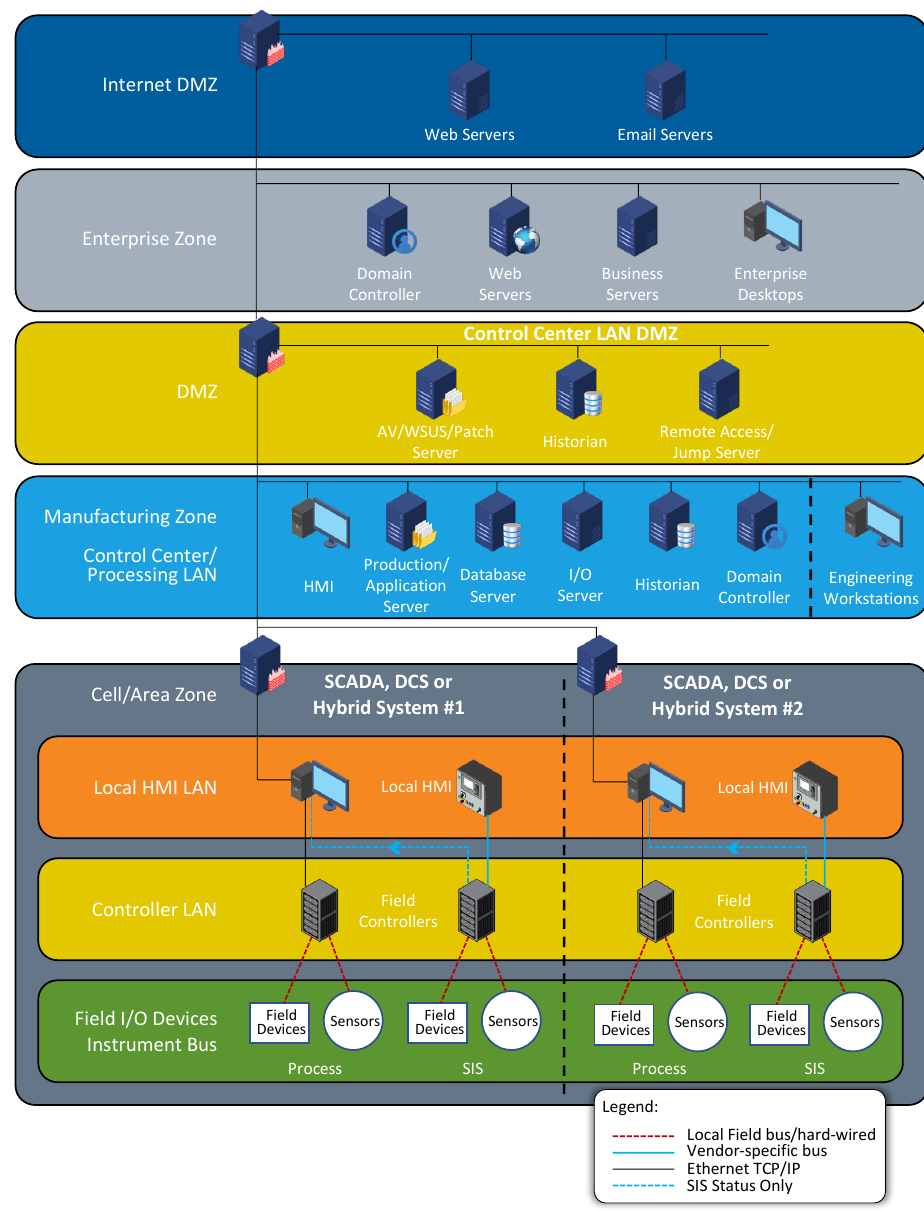
Figure 4. CISA Recommended Secure